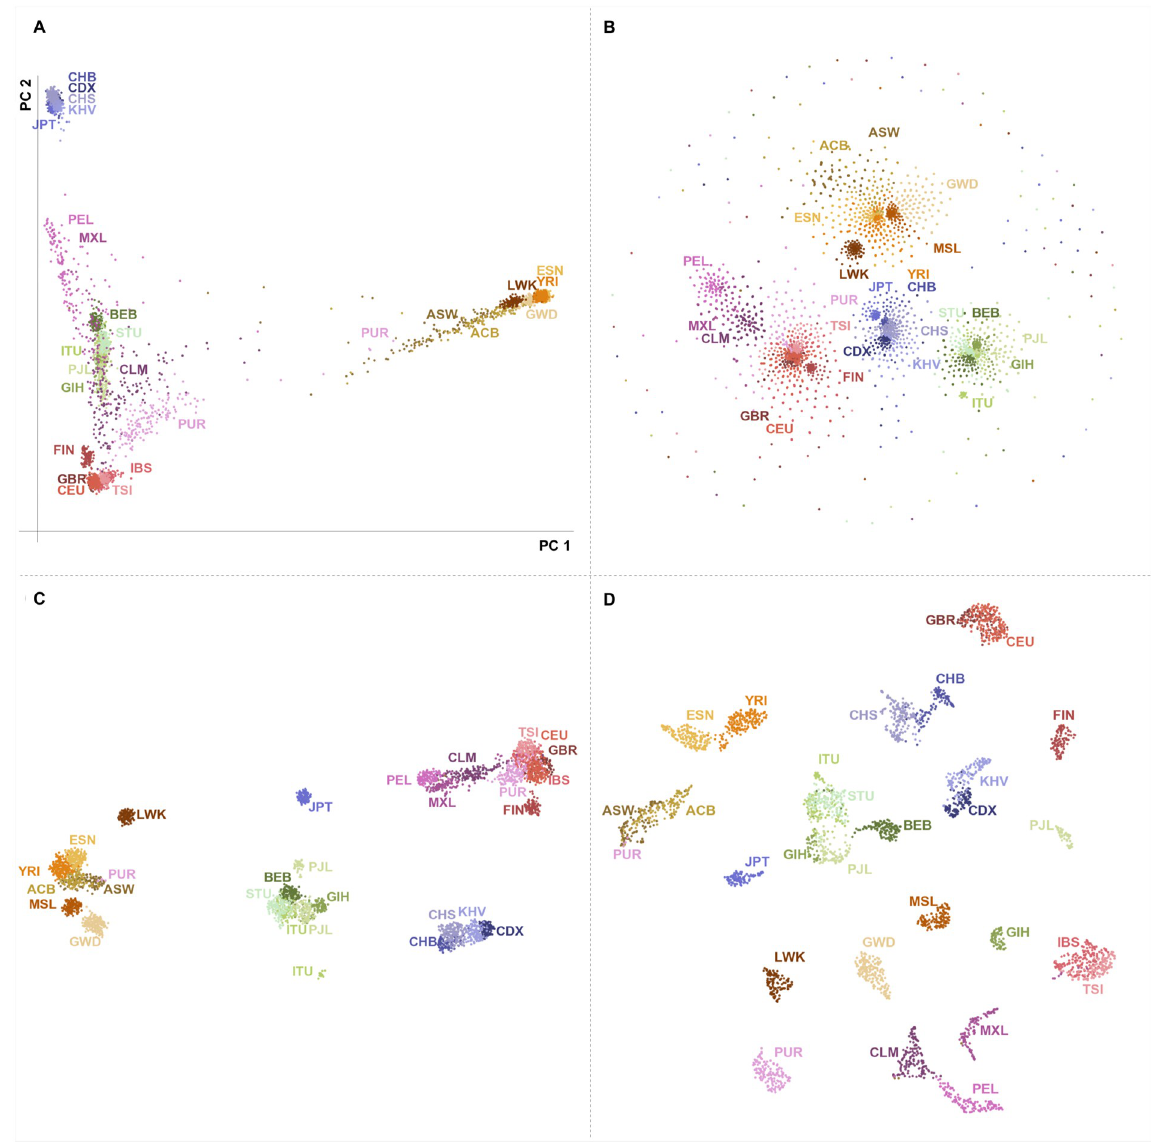
Fig 1. Four methods of dimension reduction of 1KGP genotype data with population labels. ( A ) PCA maps individuals in a triangle with vertices corresponding to African, Asian, and European continental ancestry. Discarding lower-variance PCs leads to overlap of populations with no close affinity, such as Central and South American populations with South Asians. ( B ) t-SNE forms groups corresponding to continents, with some overlap between European and Central and South American people. Smaller subgroups are visible within continental clusters. The cloud of peripheral points results from the method’s poor convergence. ( C ) UMAP forms distinct clusters related to continent with clearly defined subgroups. Japanese, Finnish, Luhya, and some Punjabi and Telugu populations form separate clusters consistent with their population history [12]. ( D ) UMAP on the first 15 principal components forms fine-scale clusters for individual populations. Groups closely related by ancestry or geography, such as African Caribbean/African American, Spanish/Italian, and Kinh/Dai populations cluster together. Results using t-SNE on principal components are presented in S1 Fig. Axes in UMAP and t-SNE are arbitrary. Since the algorithms prioritize local distances, long distances between clusters are not meaningful. ACB, African Caribbean in Barbados; ASW, African Ancestry in Southwest US; BEB, Bengali; CDX, Chinese Dai; CEU, Utah residents with Northern/Western European ancestry; CHB, Han Chinese; CHS, Southern Han Chinese; CLM, Colombian in Medellin, Colombia; ESN, Esan in Nigeria; FIN, Finnish; GBR, British in England and Scotland; GWD, Gambian; GTH, Gujarati; IBS, Iberian in Spain; ITU, Indian Telugu in the UK; JPT, Japanese; KHV, Kinh in Vietnam; LWK, Luhya in Kenya; MSL, Mende in Sierra Leone; MXL, Mexican in Los Angeles, California; PEL, Peruvian; PJL, Punjabi in Lahore, Pakistan; PUR, Puerto Rican; STU, Sri Lankan Tamil in the UK; TSI, Toscani in Italy; YRI, Yoruba in Nigeria.